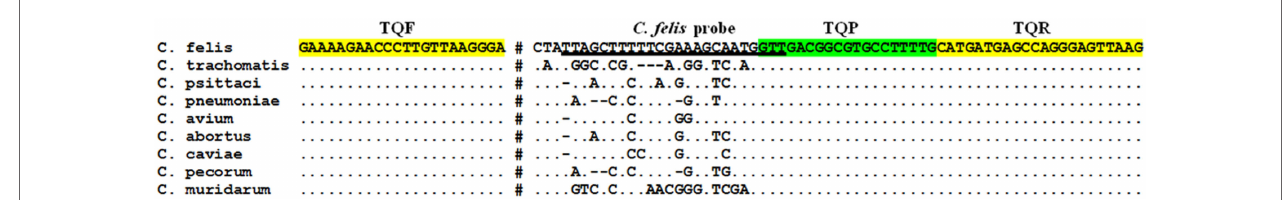
FIGURe 3 | 23S rRNA gene fragment as target for the pan- Chlamydia PCR. The primers (TQF and TQR) are highlighted in yellow, and the pan- Chlamydia probe (TQP) in green. The DNA sequence used as C. felis -specific probe (this study) is underlined. Note that despite the overlap of the two probes, there is no interference in detection because they bind to complementary DNA strands. 44 bp of conserved sequences are blanked out (marked by #). GenBank accession numbers for the aligned sequences are: C. felis (NR_076260, bp 516–646), C. trachomatis (NR_103960), C. psittaci (NR_102574), C. pneumoniae (NR_076161), C. avium (NR_121988), C. abortus (NR_077001), C. caviae (NR_076195), C. pecorum (NR_103180), C. muridarum